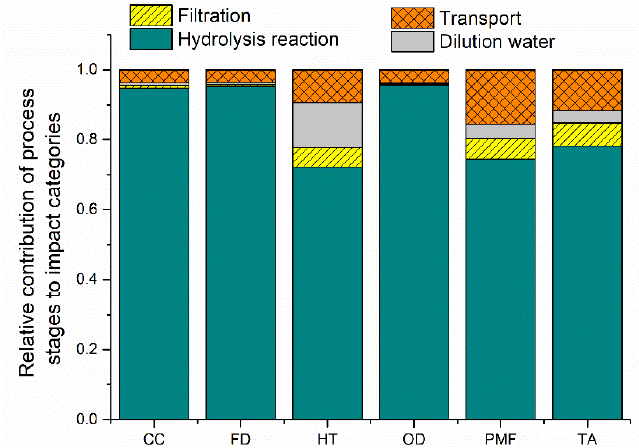
Figure 5. LCA results obtained for the relative contribution of process stages to the evaluated impact categories in glucose production from maize starch, excluding starch manufacture.